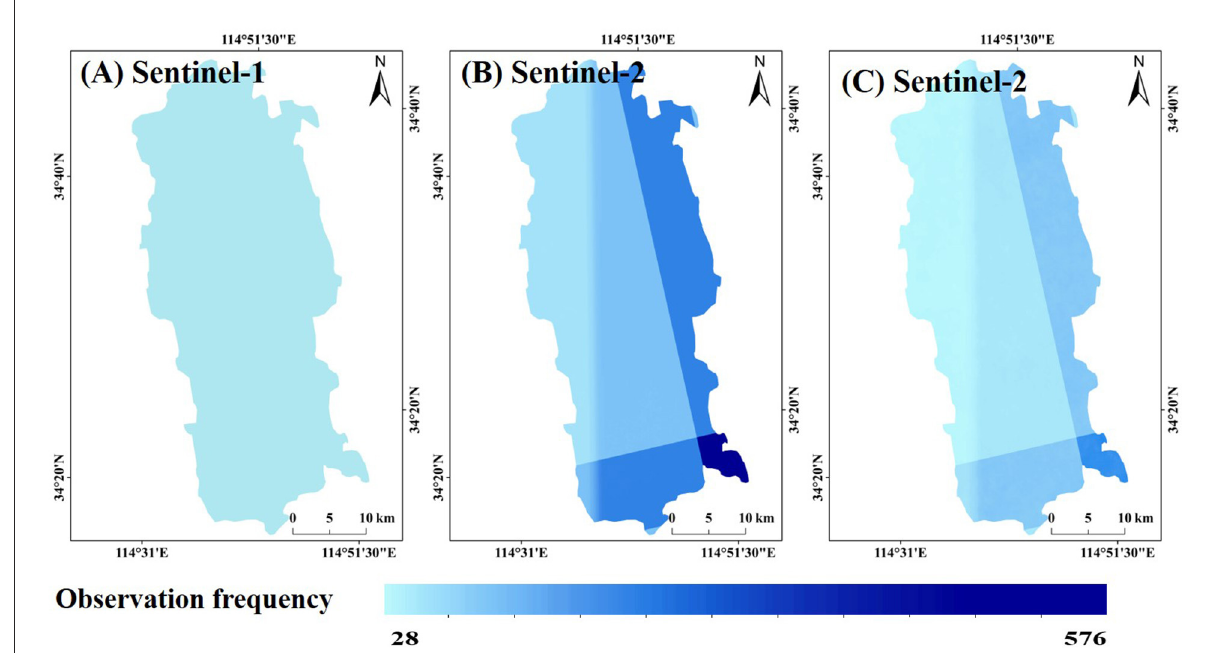
FIGURE3 Numbers of observations for individual pixels during the study period. (A,B) The spatial distributions of total observations for individual pixels for S1 and S2. (C) The spatial distributions of good-quality observations for individual pixels for